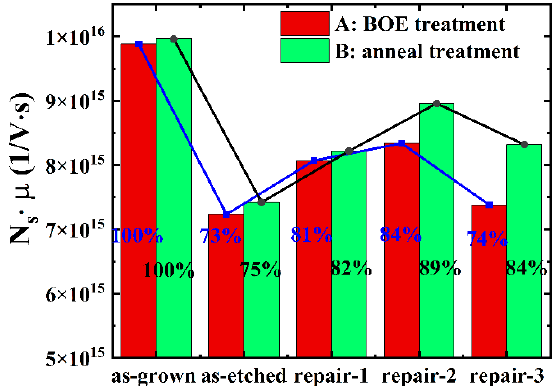
Figure 3. The product of the N s and the μ of sample A and sample B in different states.